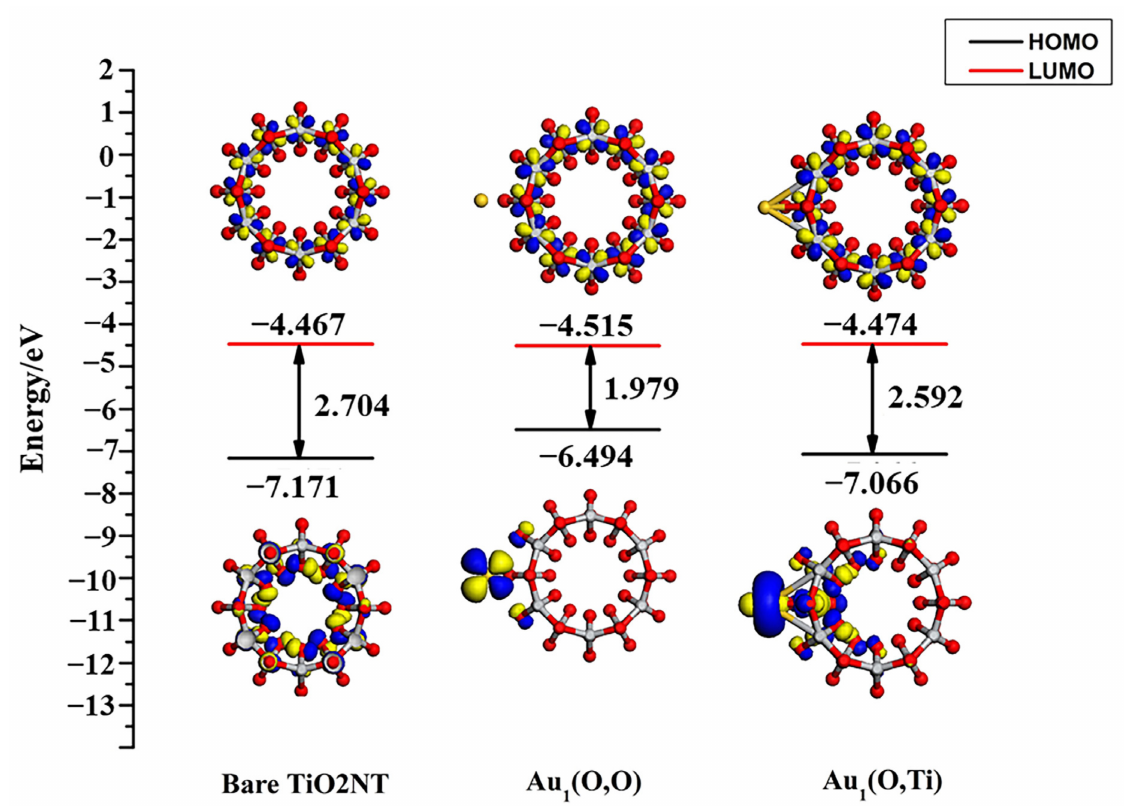
Figure 4. HOMO and LUMO along with the energy gap of bare TiO 2 NT and two Au 1 adsorption systems calculated at the Γ -point. The isovalue set is 0.025 electrons/Å 3 . The gold atoms are shown in gold, the oxygen atoms are displayed in red, while titanium atoms are presented in light gray. Blue and yellow regions represent the positive and negative parts of HOMO and LUMO